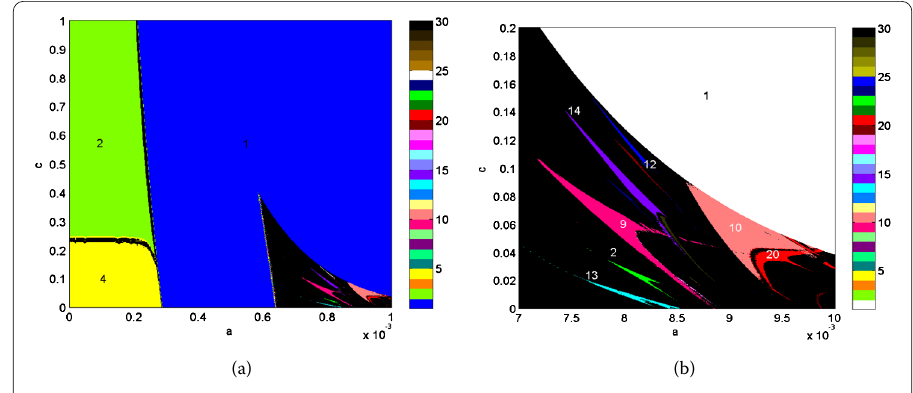
Figure 2 Attractor region of different periods. (a) The 2D projection onto the ( a , c ) plane of equation (1.2); (b) The magnification of (a). In this and further similar plots, different attractors are identified by different colors and numbers. For the sake of beauty, the period-1 is shown in white for (b).